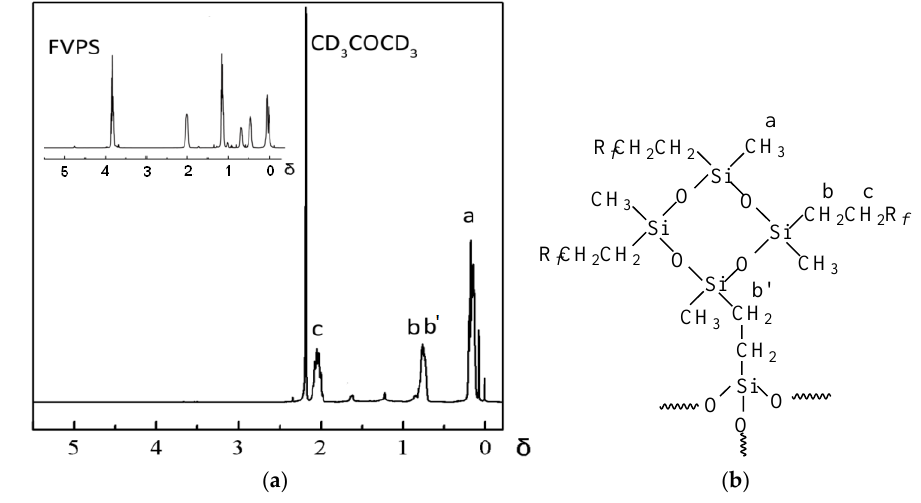
2 , and ( c ) SiO 2 sol.